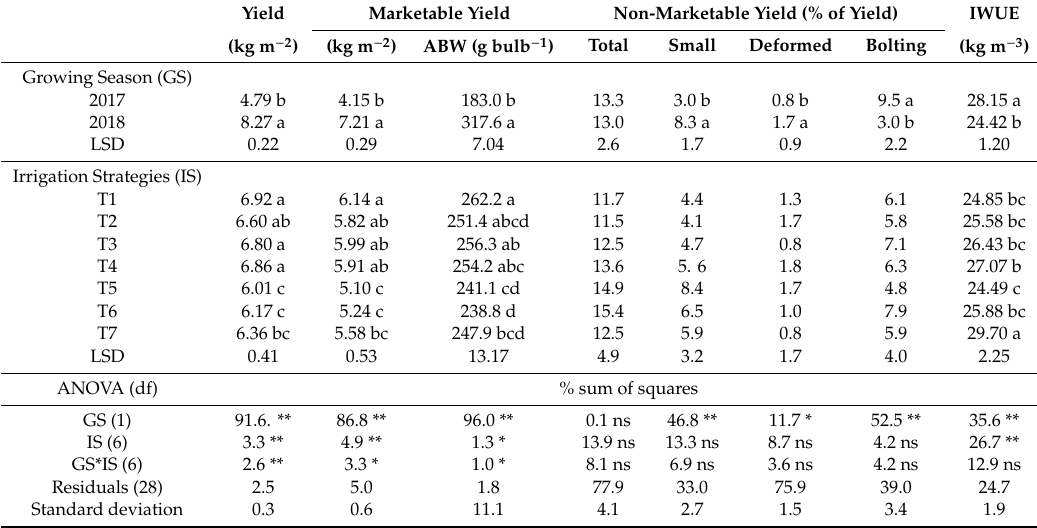
df: degrees of freedom. Mean values followed by di ff erent lower-case letters in each column indicate significant di ff erences at p ≤ 0.05 using the LSD test. ** (*), indicate significant di ff erences at p ≤ 0.01 ( p ≤ 0.05). ns, indicates no significant di ff erences. Table 5. E ff ects of the growing season and the irrigation strategy on the total yield (Yield); marketable yield; average bulb weight (ABW); non-marketable yield and its partitioning in small, deformed, and bolting bulbs; and irrigation water use e ffi ciency